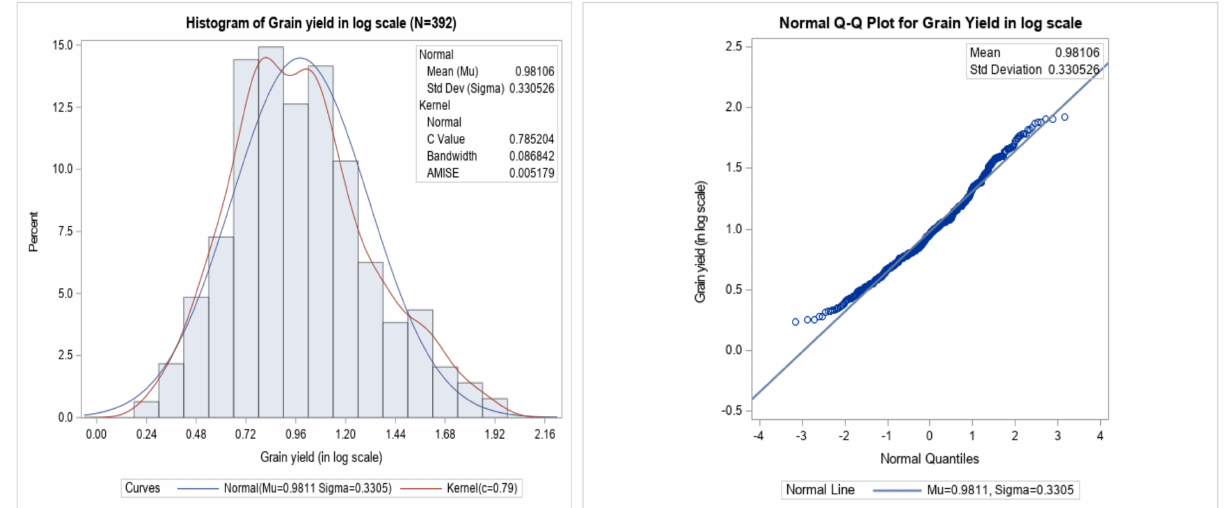
Figure 2. Histogram and Q-Q plot of the new data set.